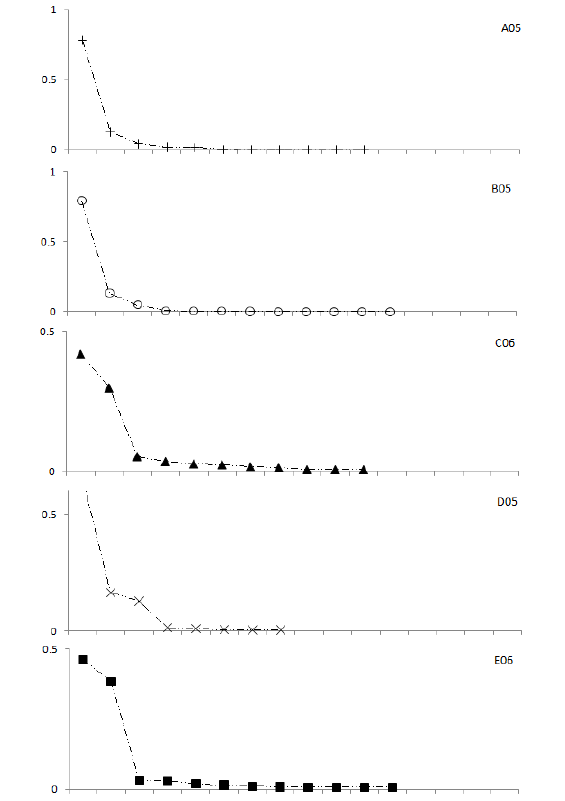
Figure 1. Pollen diversity represented by the relative frequency and the rank in the honey samples (A05, B05, C06, D05, E06, F05, G06, H06, I06, L, M). Unfilled symbols represent the low diversity group 1 that is dominated by pollen from a restricted number of few plant species. Filled symbols represent the high diversity group 2 samples with pollen from many plants and an even representation of